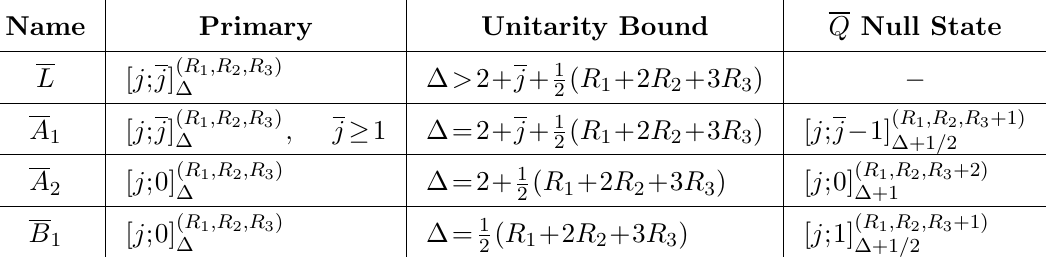
Table 20 . Q shortening conditions in four-dimensional N = 4